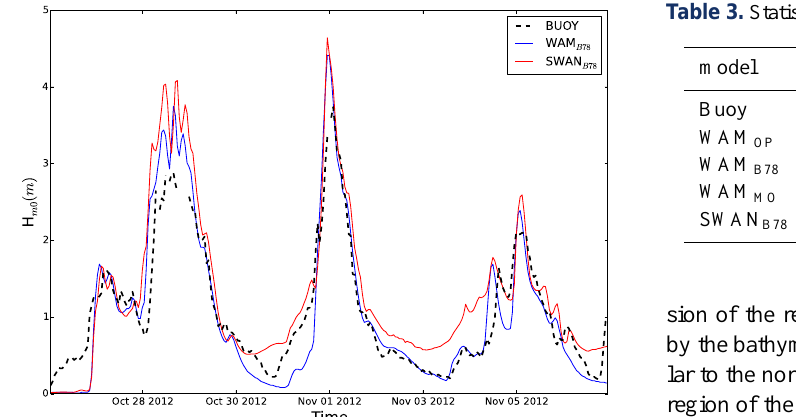
Figure 15. Test-case 1: comparison between SWAN B78 and WAM B78 at Venice buoy location.